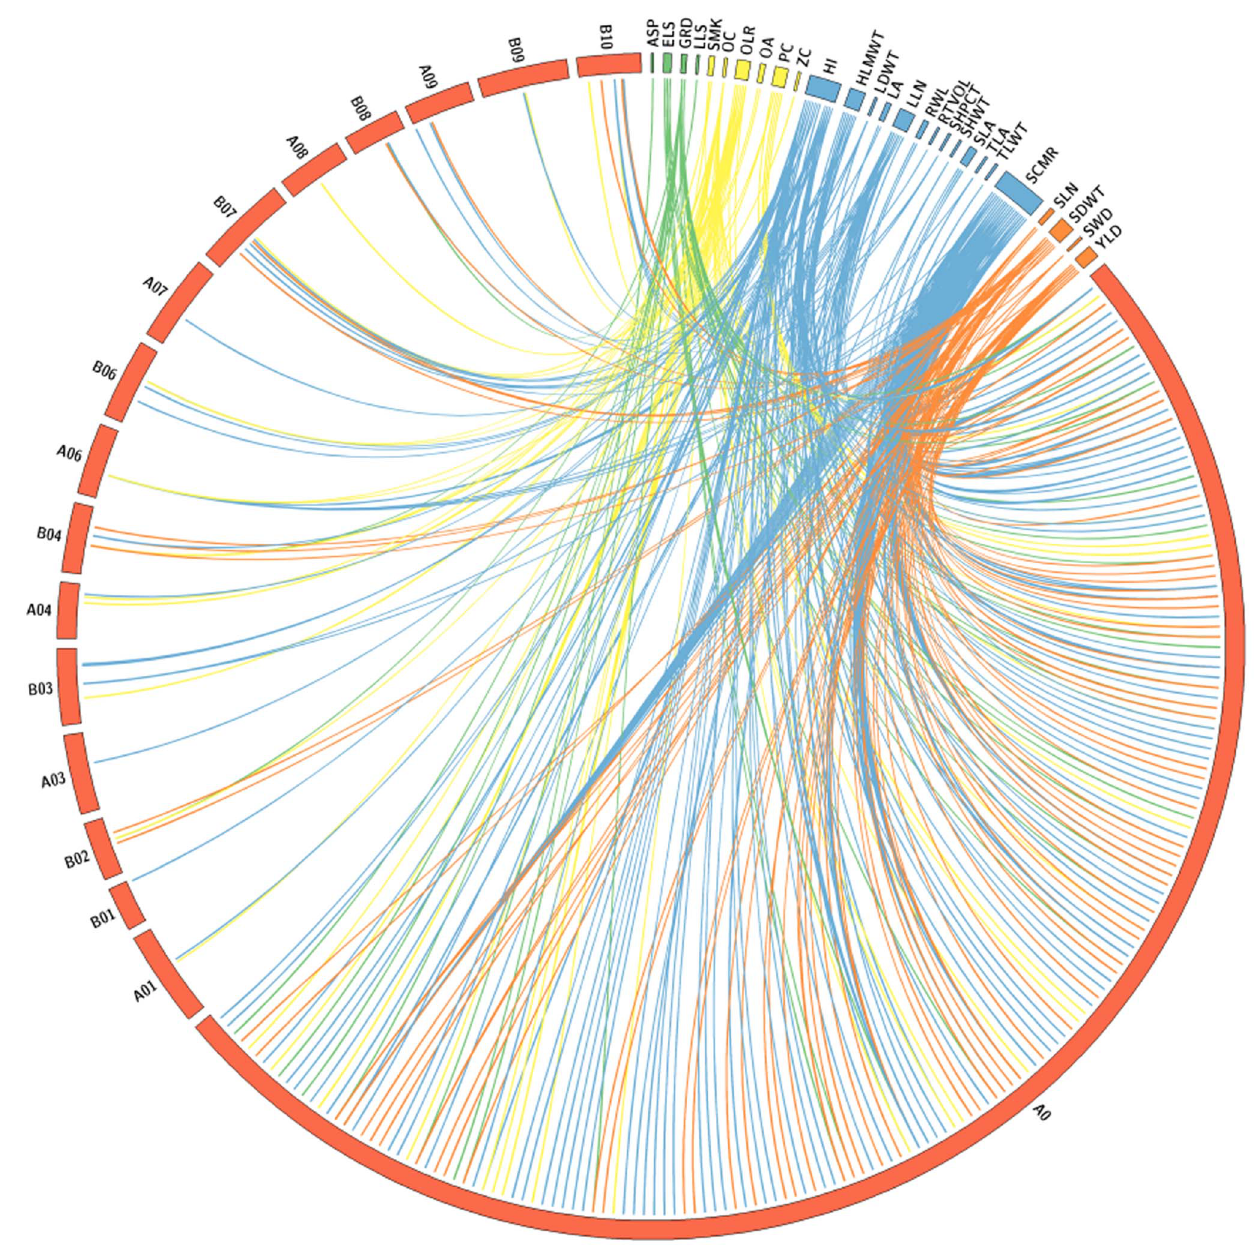
Figure 4. Global distribution of genotypes containing linked-marker allele(s) for different economically important traits in peanut. An attempt has been made to show passport-based geographical distribution of genotypes that had favourable alleles for markers showing association and explaining . 20% phenotypic variation for the trait. Genotypes containing favourable alleles for different traits have been represented by circles in different colors.